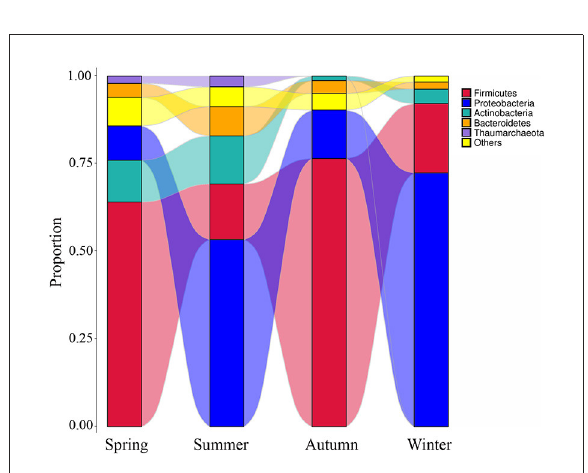
FIGURE4 The microbial composition of the air of broiler house in different seasons. The Sankey Diagram was constructed with the relative abundance of OTUs to determine the bacteria composition of different seasons in the broiler